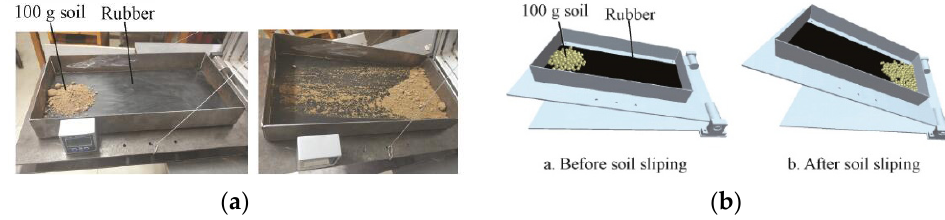
Figure 7. Sliding test and simulation test of soil on rubber. ( a ) Sliding test; ( b ) Simulation test [91].